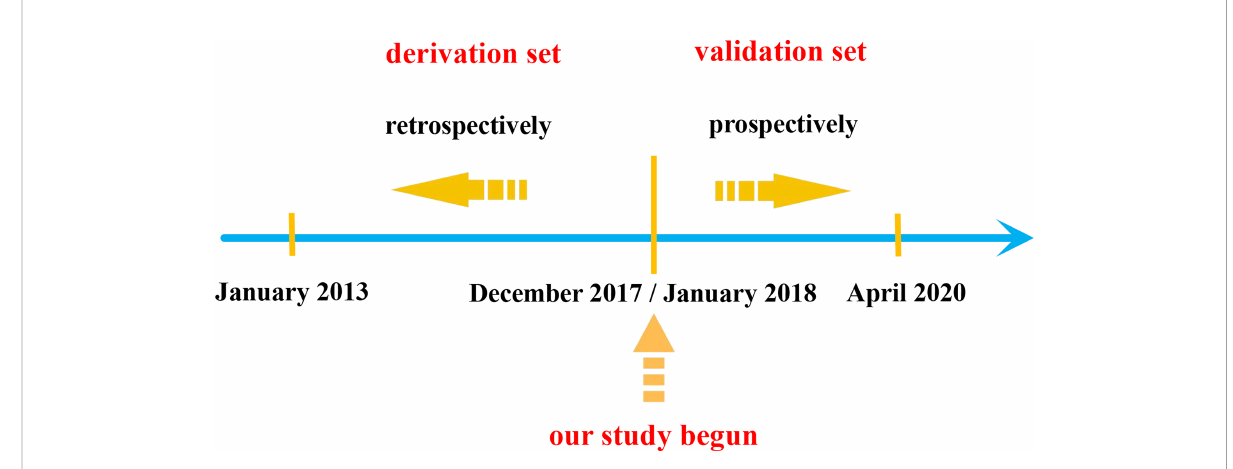
FIGURE 1 Schematic of patient inclusion in derived and validation sets in this